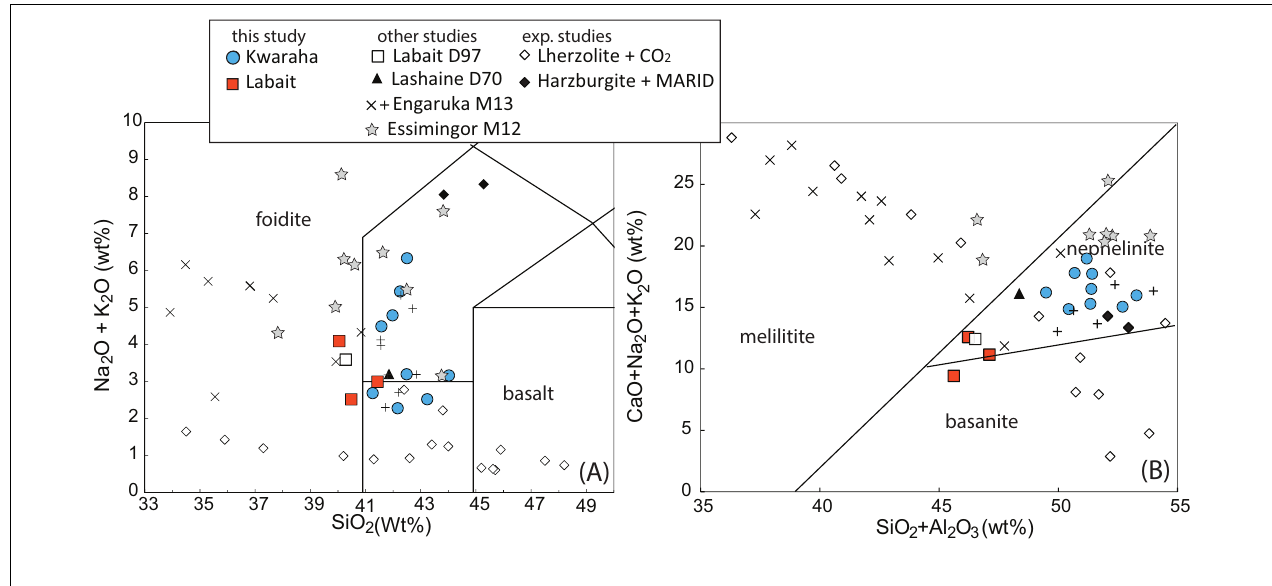
FIGURE 3 | Geochemical classification of sampled lavas from Kwaraha (circles) and Labait (squares). (A) Alkali vs. silica composition (B) melilitite-nephelinite-basanite classification (Le Bas, 1989). Whole rock data are recalculated anhydrous to 100%. We also reported literature data from Labait and Lashaine (triangle) lavas (Dawson et al., 1970, 1997, respectively), Essimingor lavas (gray stars; Mana et al., 2012), melilitites (plus) and nephelinites (cross) from Engaruka volcanic field (Mattsson et al., 2013). Experimental melt compositions from partial melting of lherzolite + CO 2 (open diamonds; Dasgupta et al., 2007) and Harzburgite + MARID (black squares; Förster et al., 2018) are also